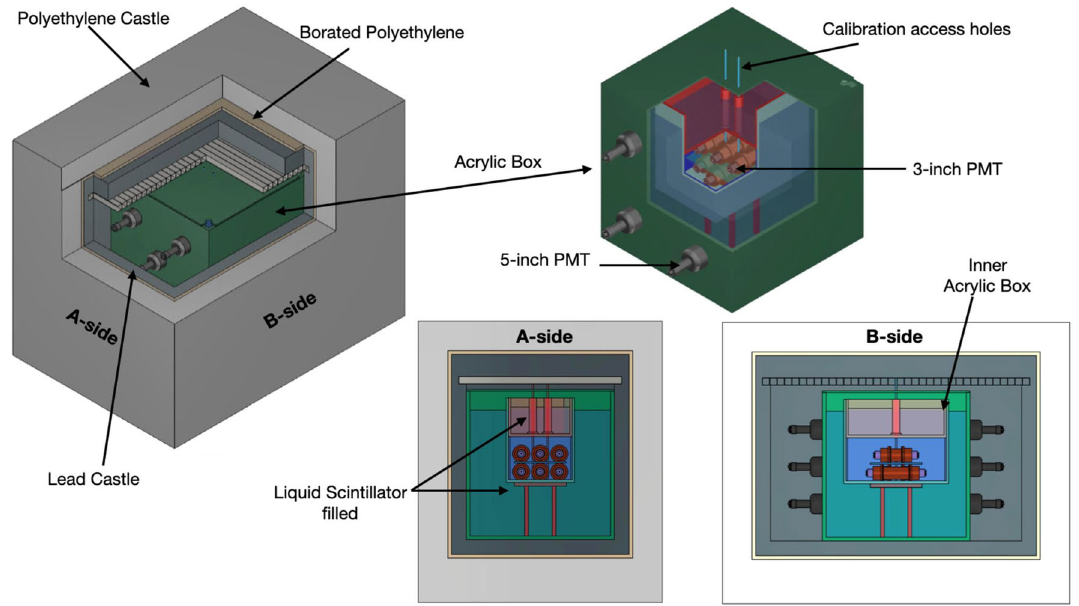
Fig. 2 NEON shielding overview. From outside inward, a polyethy- lene castle and borated polyethylene boards, a lead brick castle, stainless-steel pipes, and acrylic box (2 . 5 cm thick) with ten 5-inch PMTs and six encapsulated crystal detectors immersed in the liquid